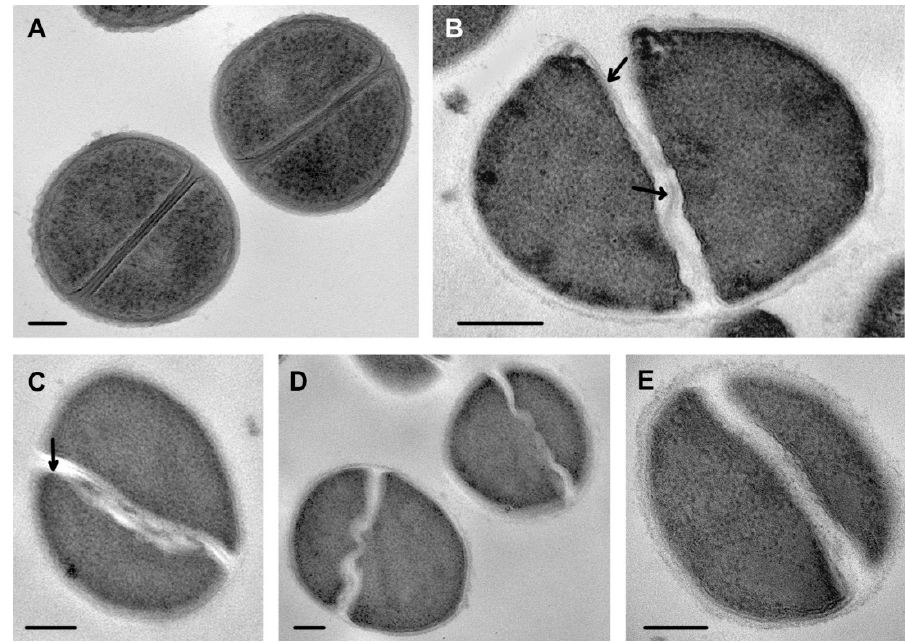
Figure 10. Damage to septa in S. aureus incubated with chlorhexidine. ( A ) control cells; ( B ) incubated for 15 min; ( C , D ) for 45 min; ( E ) 2 h. Arrows show cell wall in damaged septa. TEM of ultrathin sections. Scale bars correspond to 200 nm.